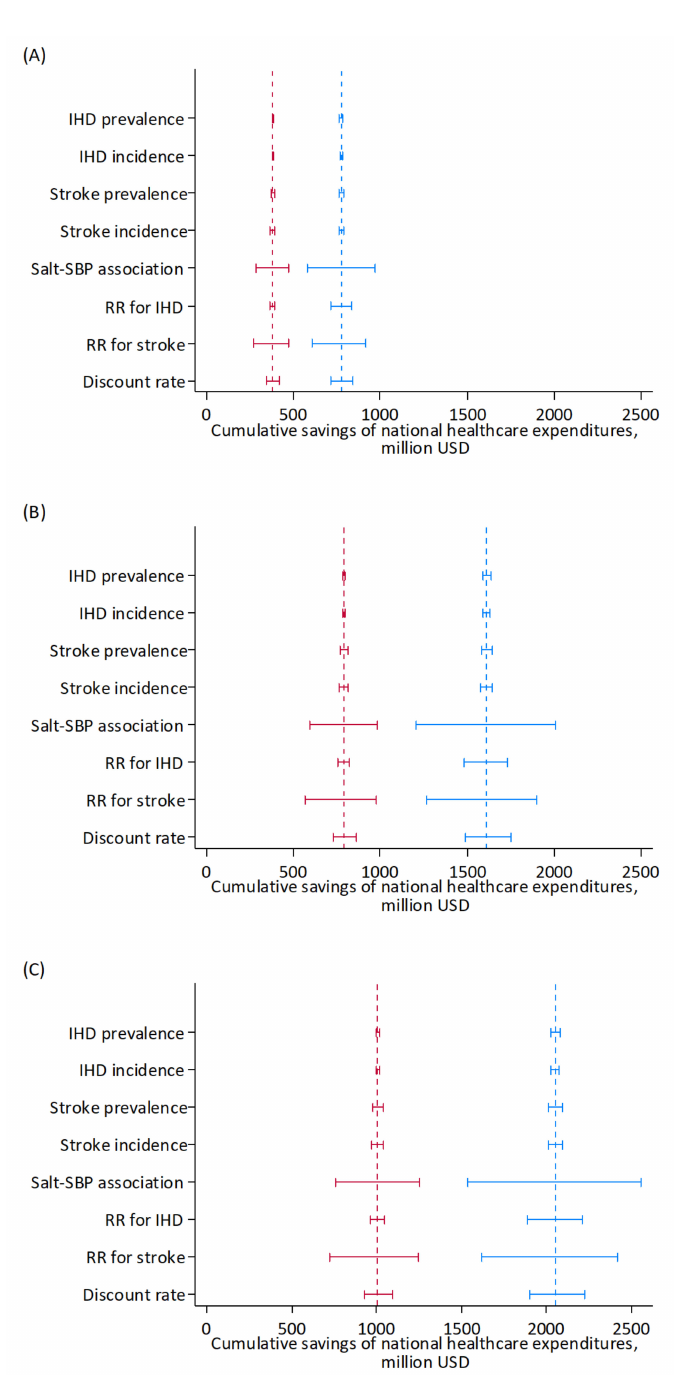
Figure 5. Results of the one-way sensitivity analyses of key input parameters on projected cumulative savings of national healthcare expenditures for IHD and stroke by reducing mean dietary salt intake to 8 g/day ( A ), <6 g/day ( B ), and <5 g/day ( C ) between the years 2019 and 2029 in a closed cohort of population aged 40–79 years in 2019. Blue, men; red, women. Range plots with spikes indicate uncertainty ranges. Dashed lines indicate expected values. IHD, ischemic heart disease; RR, relative risk, SBP: systolic blood